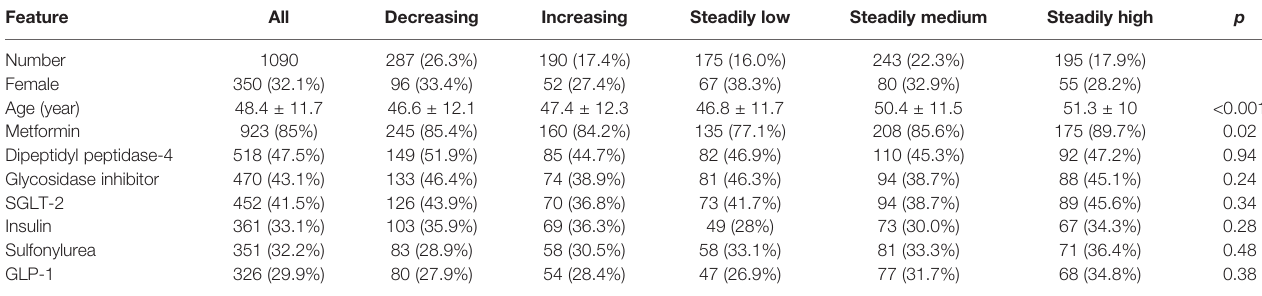
TABLE 1 | Clinical features of patients with T2DM strati fi ed by dietary salt intake.